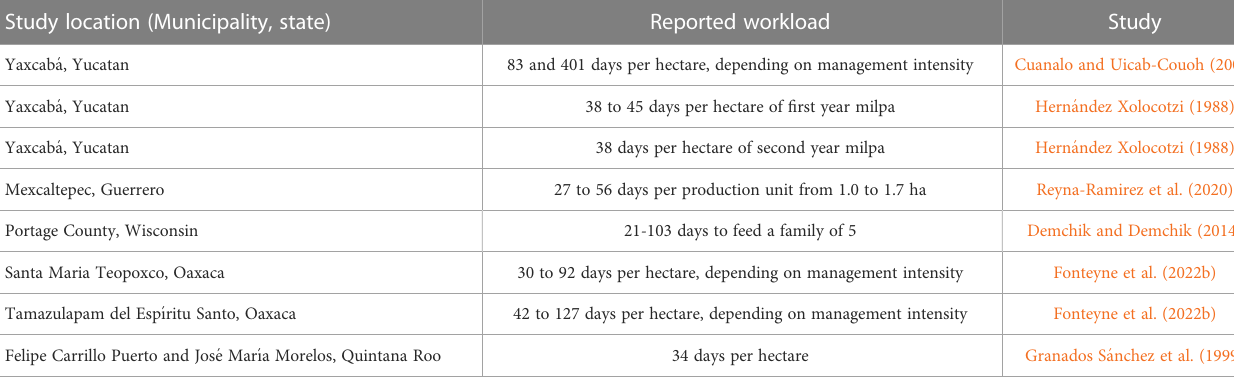
TABLE 1 Workload to grow one year of milpa reported in the scienti fi c